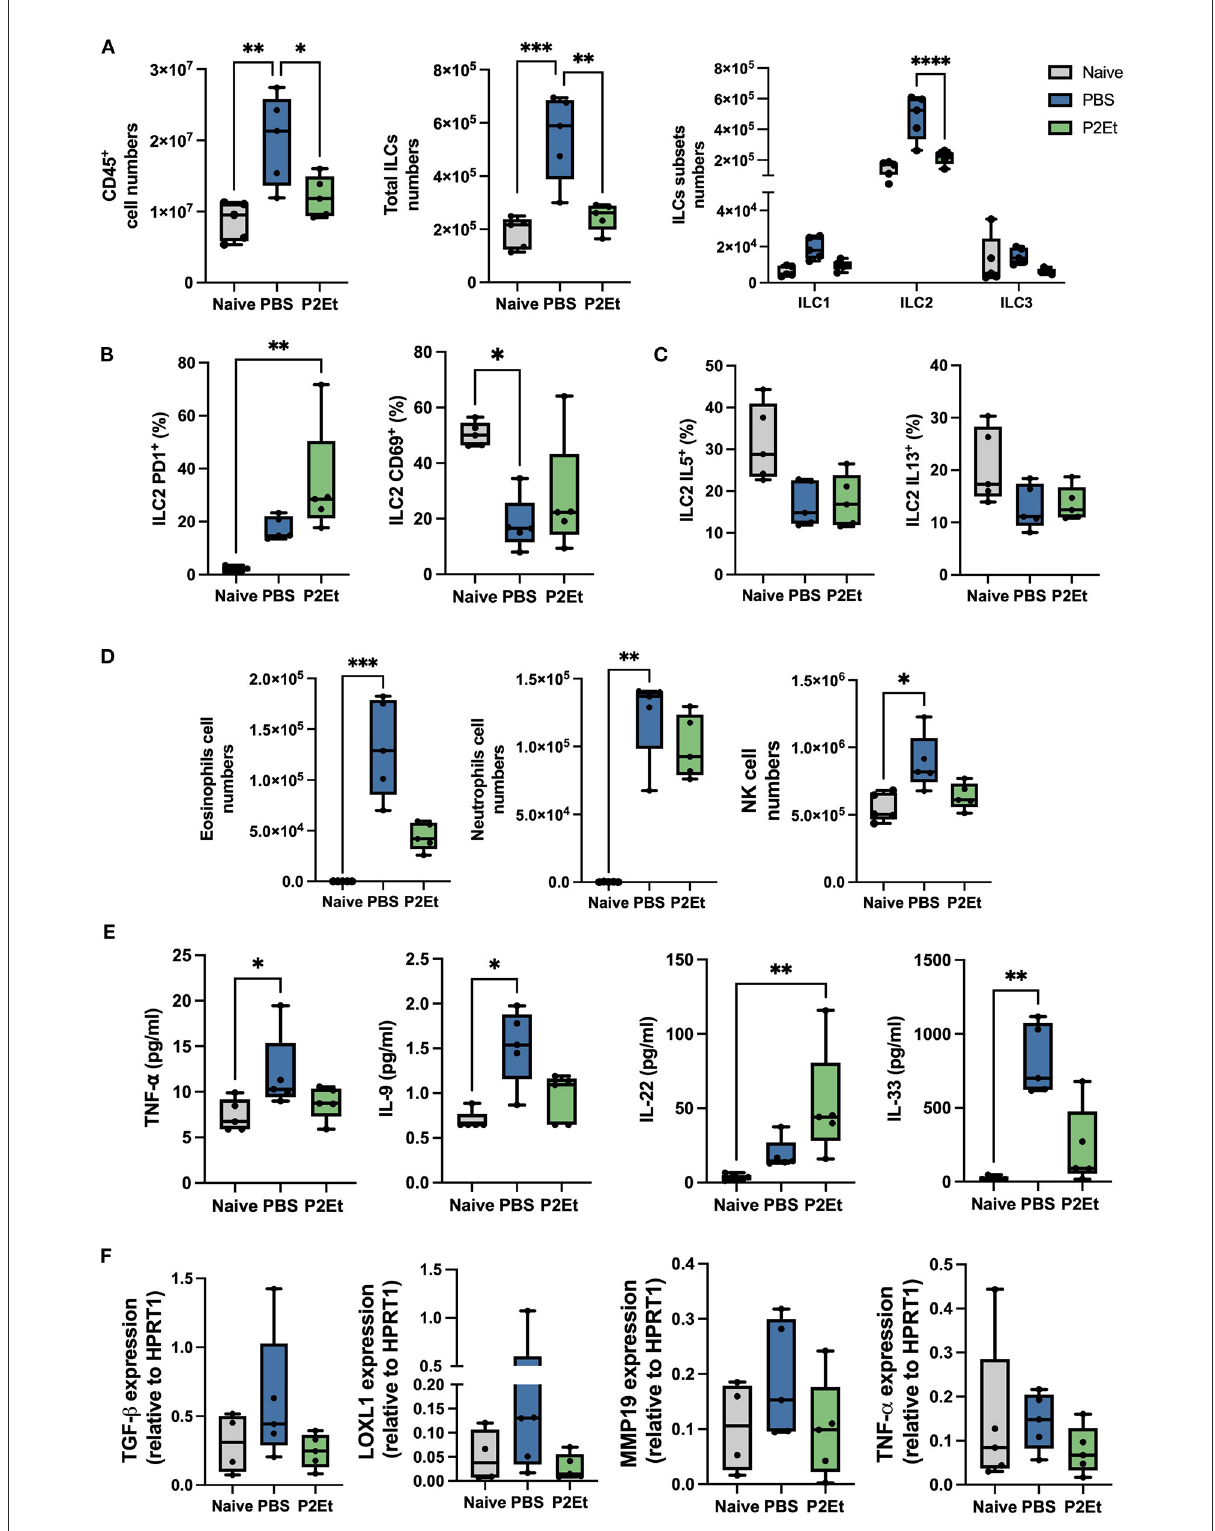
FIGURE5 P2Et treatment reduces ILC2 the pro-fibrotic factors in the lung of bleomycine challenged mice. (A) Lungs from naïve animals were used as negative controls compared and to bleomycine challenged animals treated either with PBS or P2Et. Absolut counts from lung ex vivo samples are shown. (B) Frequency of PD1 and CD69 positive cells among the ILC2 subset is presented. (C) Part of the lung cell suspension was used for an